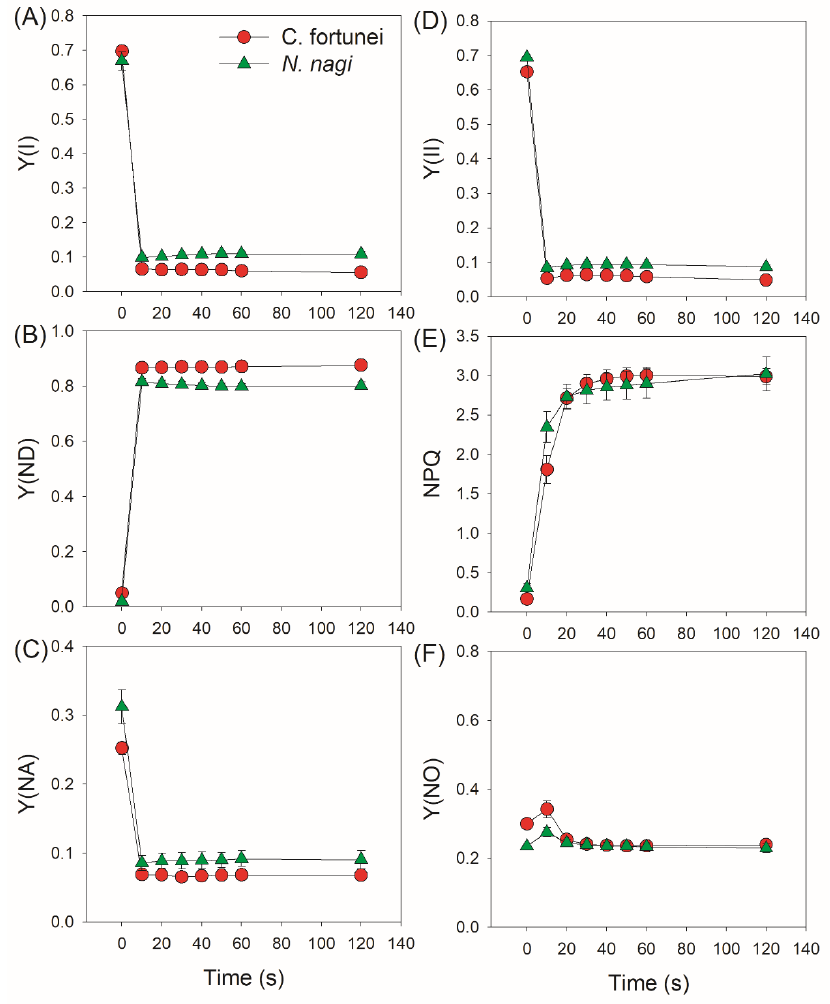
Figure 2. Changes in the quantum yields of PSI and PSII after transition from 59 (t = 0) to 1809 μmol photons m −2 s −1 in leaves of Cyrtomium fortune and Nageia nagi . ( A ) Y(I) represents the quantum yield of PSI photochemistry; ( B ) Y(ND), the quantum yield of PSI non-photochemical energy dissipation due to donor side limitation; ( C ) Y(NA), the quantum yield of PSI non-photochemical energy dissipation due to acceptor side limitation; ( D ) Y(II) represents the quantum yield of PSII photochemistry; ( E ) NPQ, non-photochemical quenching in PSII; ( F ) Y(NO), the quantum yield of PSII non-regulatory energy dissipation. The data are the means ± SE (n = 5).